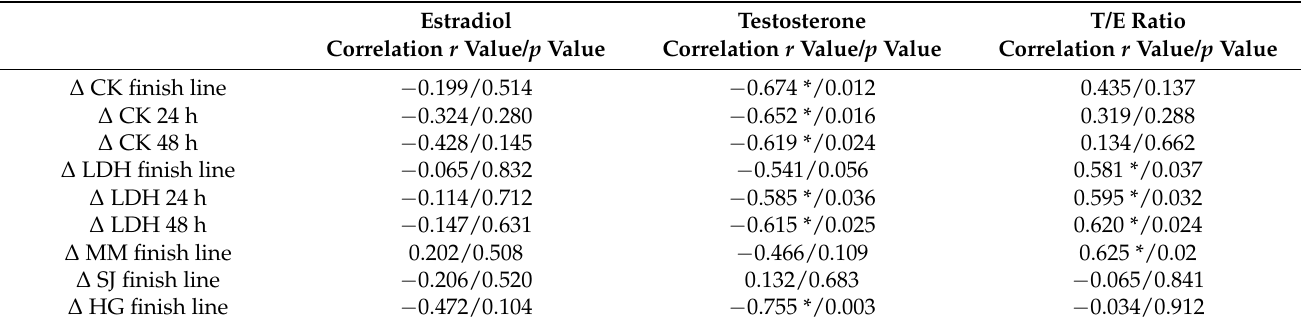
Table 2. Spearman correlations between sex hormones, muscle fatigue variables, and indirect markers of muscle damage.